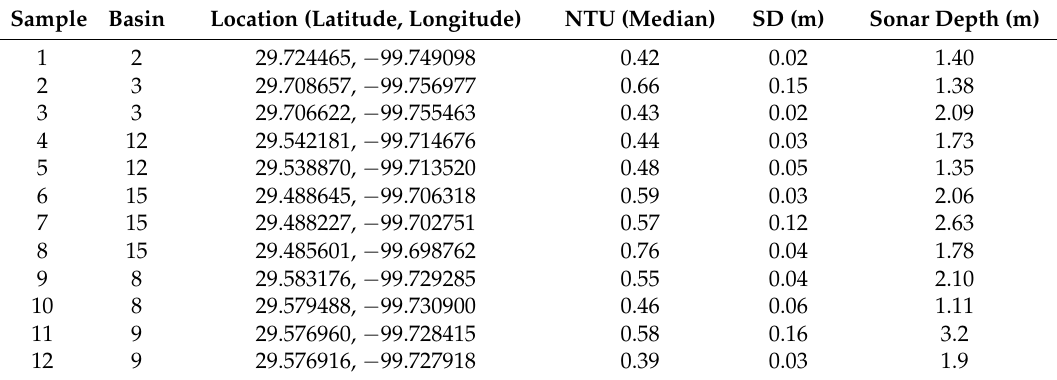
Table 6. Turbidity and depth measurements at selected locations in the Frio